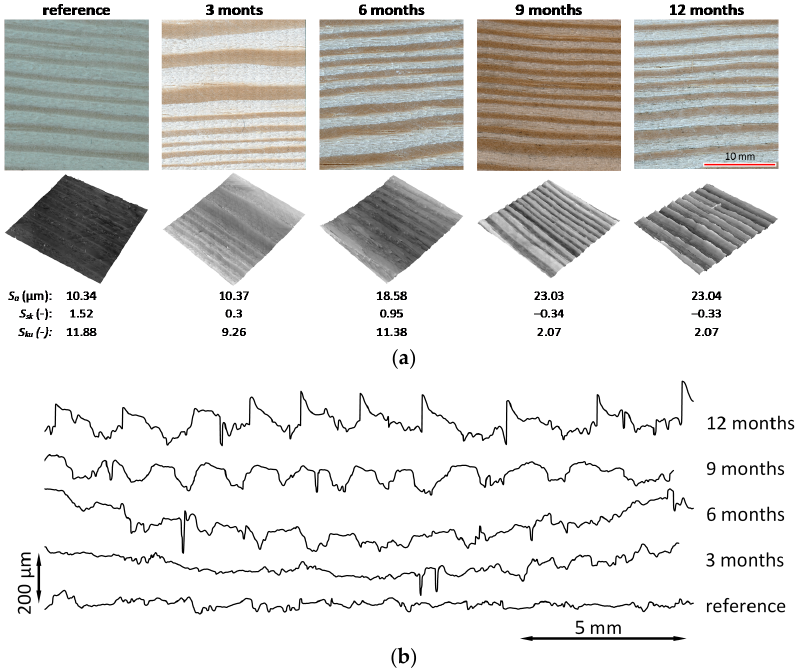
Figure 6. 3D surface topography map, typical surface profiles and high magnification images of the Scots pine wood exposed to natural weathering for 12 months, ( a ) high magnification images and 3D surface topography map, ( b ) typical surface